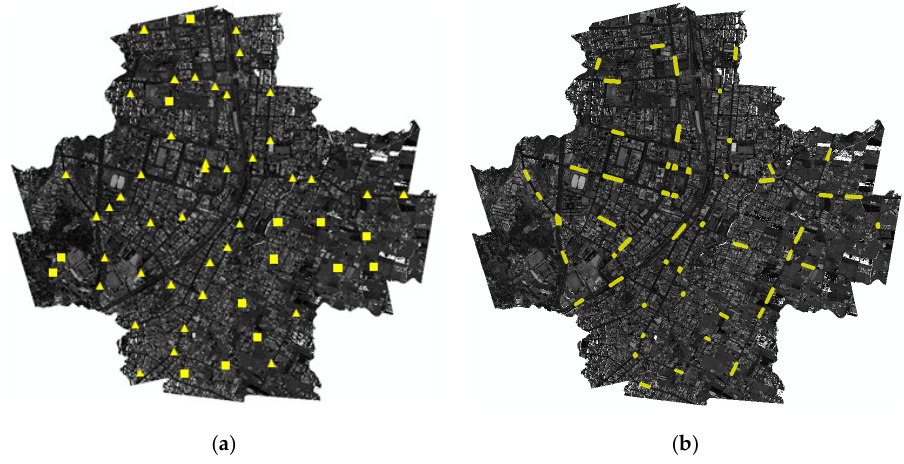
Figure 5. The distribution of tie regions: ( a ) ground control regions (GCR) by automatic tie region selection, the triangles indicate road regions and squares indicates rooftop regions; and ( b ) independent check regions (ICR) by manual selection. ( b ) independent check regions (ICR) by manual selection.